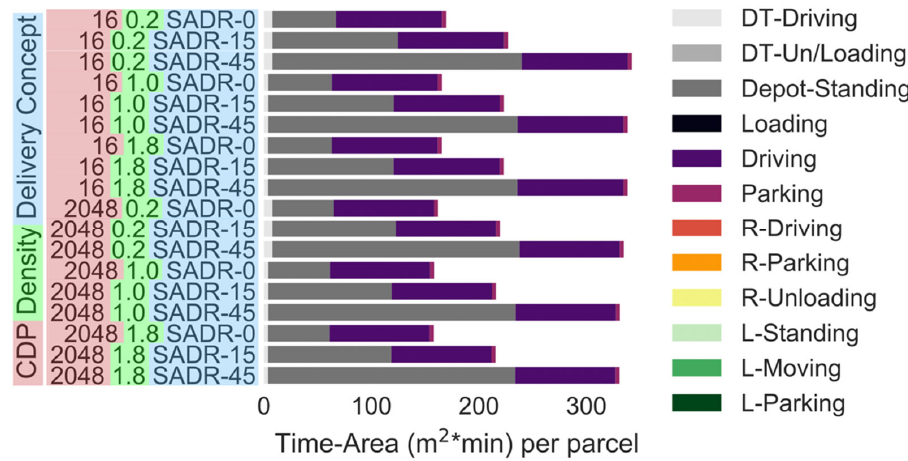
Figure 10. Time ‐ area requirements of SADRs (number of CDPs: 16 or 2048). Parcel demand level: Figure 10. Time-area requirements of SADRs (number of CDPs: 16 or 2048). Parcel demand level: 0.2: 20% of the current demand, 1.0: current demand, 1.8: 80% increase in the demand. x -axis, different scale.